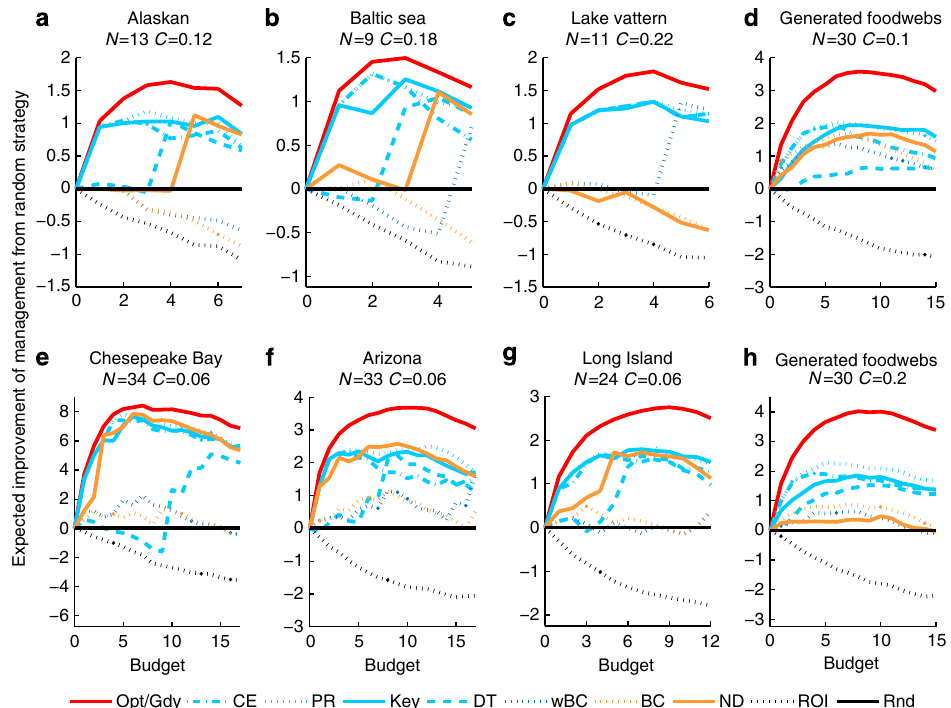
Figure 1 | Expected performance of food web management based on each index/approach compared to a random strategy. Performance is the number of species surviving and is averaged across 100 simulations of extinction risk (drawn from a Beta distribution with a ¼ 2 and b ¼ 8) and interaction strengths (drawn from a lognormal distribution with log-mean—3.0 and log-s.d.—1.5) for six real food webs ( a – c , e – g ) , and 10 iterations for 20 hypothetical food webs with a connectance of 0.1 ( d ) and a connectance of 0.2 ( h ). Management reduced extinction risk of a species to zero. Note, for food webs with n o 14, the performance of the optimal approach is identical to the greedy. Black, naive; orange, interactions; dark blue, interactions and strengths; light blue, interactions and trophic structure; red, all complexities. BC, Betweenness Centrality; CE, Cascading Extinction; DT, Dominator Tree; Gdy, Greedy approach; Key, Keystone Index; ND, Node Degree; Opt, Optimal approach; PR, modified Google PageRank; Rnd, Random strategy; ROI, Return-On-Investment; wBC, weighted BC. * note for clarity not all indices are